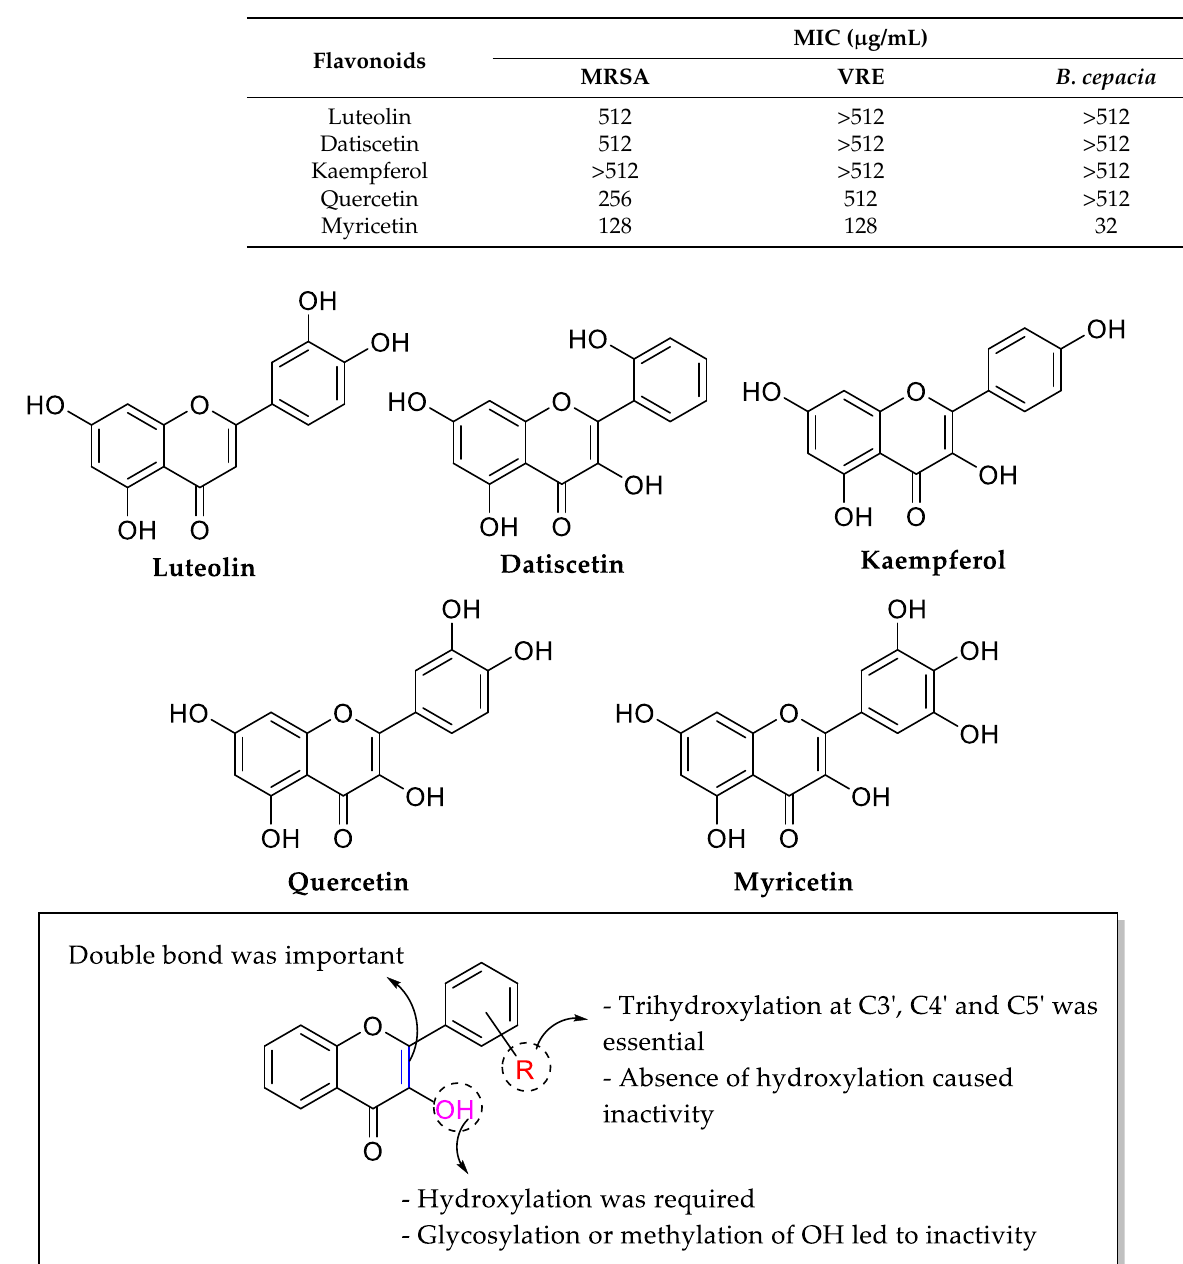
Table 6. Antibacterial activity of some selected flavonoids against several antibiotic resistant bacteria.